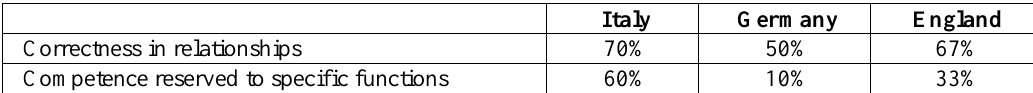
Table 11: Standard Behaviour in Relationships with Authorities and Public Institutions Correctness in relationships Competence reserved to specific functions